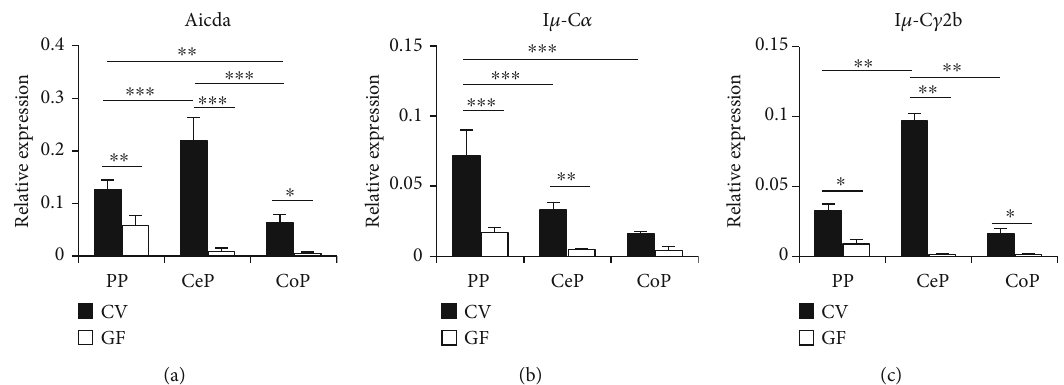
Figure 2: Analysis of gene expression to evaluate class-switch recombination in the GALT from small and large intestines. Total RNA was isolated from mononuclear cells from the GALT in CV and GF mice. The gene expression of Aicda and postswitched transcripts for IgA and IgG2b was measured by real-time PCR. Data are shown as the mean ± SD for three to fi ve independent experiments. ∗ p < 0 : 05 , ∗∗ p < 0 : 01 , and ∗∗∗ p < 0 : 001